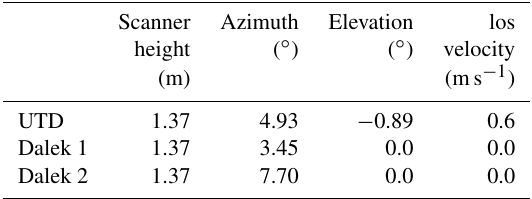
Table 3. Bias errors used for the triple-Doppler data retrieval. Table 4. Linear regression analysis among the V2 lidar, SE sonic